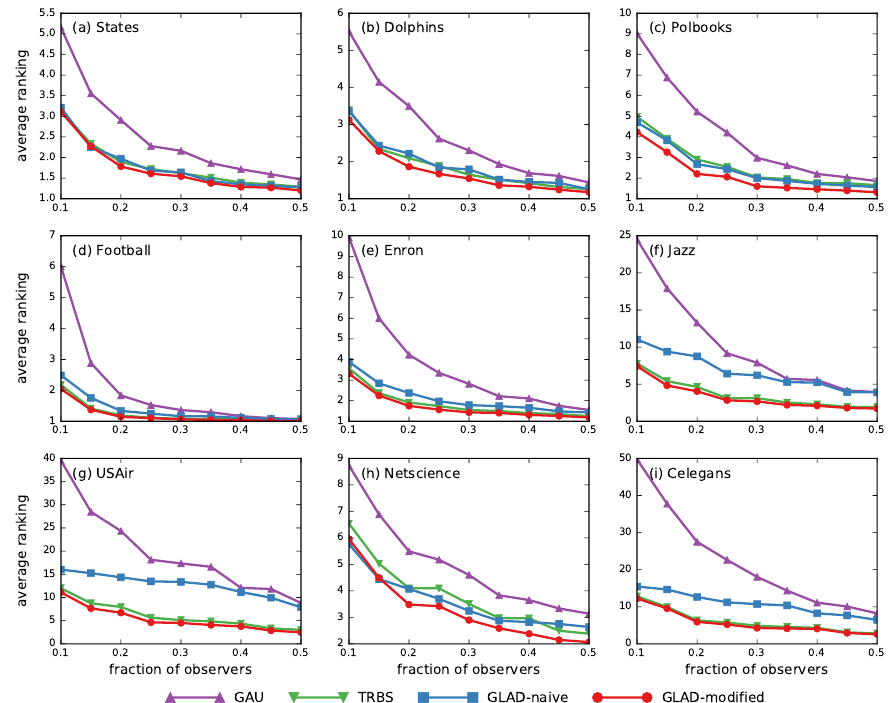
Figure 7. Average ranking of the real source by source localization algorithms on nine real networks with signal-to-noise ratio µ / σ =